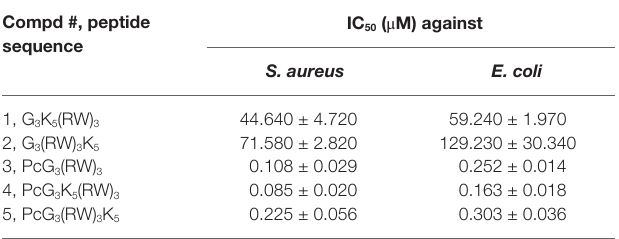
TABLE 3 | IC 50 s of antimicrobial Pc-peptides upon illumination (12 J/cm 2 , 33.33 mW/cm 2 ). Compd #, peptide